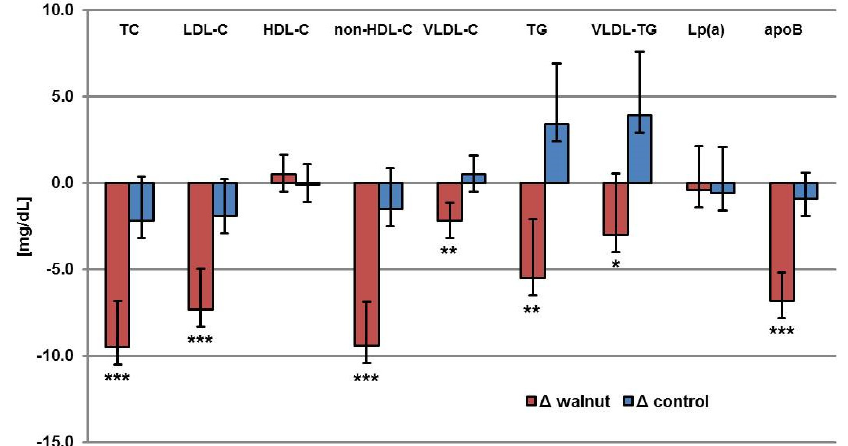
Figure 3. Changes in fasting plasma lipid levels and apoB concentrations from baseline (mg/dL) during the walnut diet phase and control diet